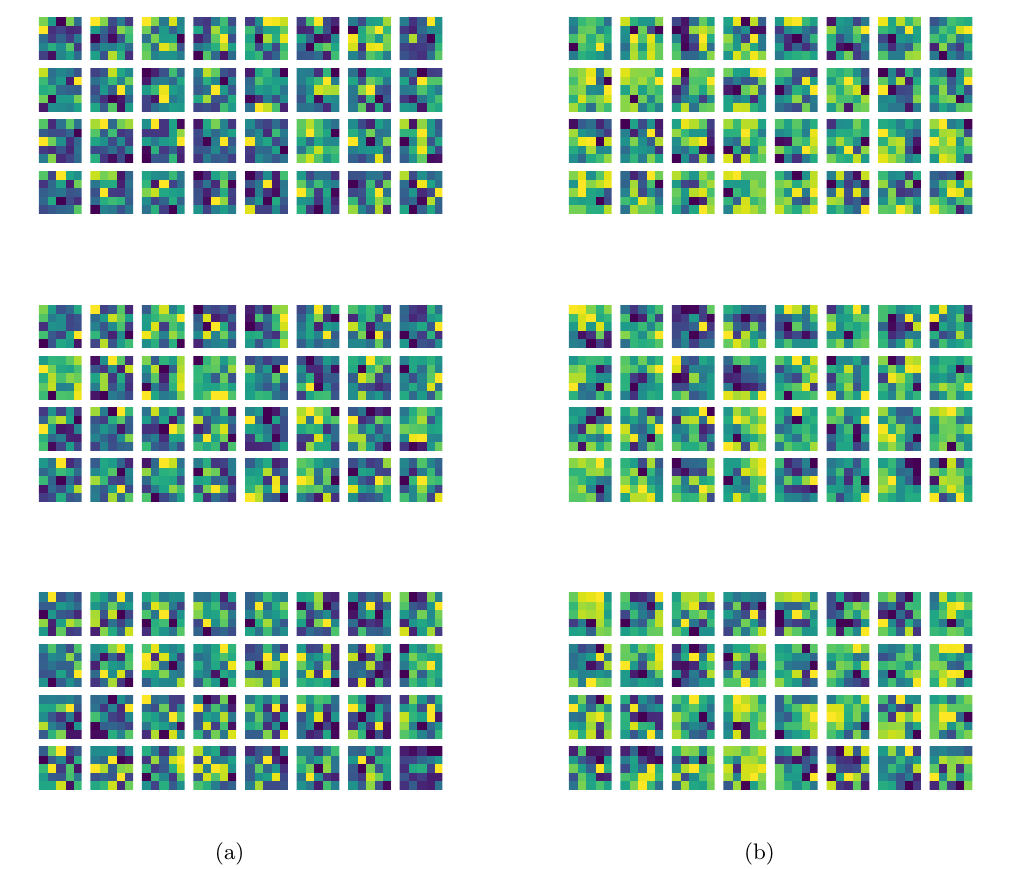
Figure 5 . The 32 (cid:12)lters from the (cid:12)rst layer of the total event CNN in (a) and the jet substructure CNN in (b). The top row (cid:12)lters correspond to the charged p T layer, the second row shows the neutral p T layer and the bottom row is for the charged-particle multiplicity